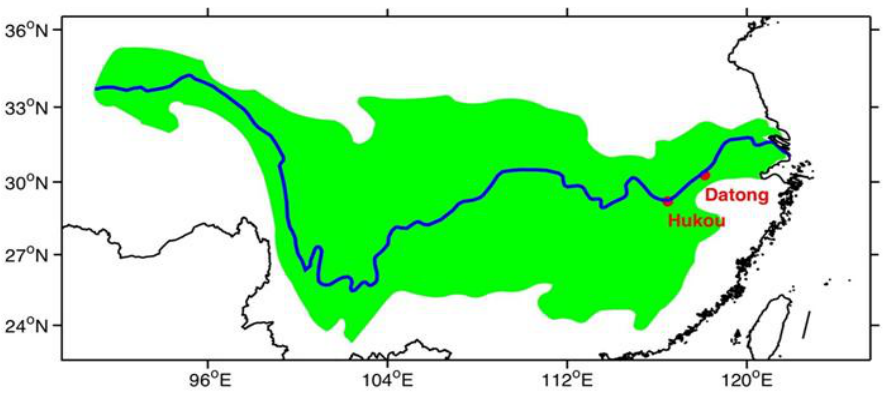
Figure 1. Map of the Yangtze River Basin with selected stations in red dots situated near the river mouth.